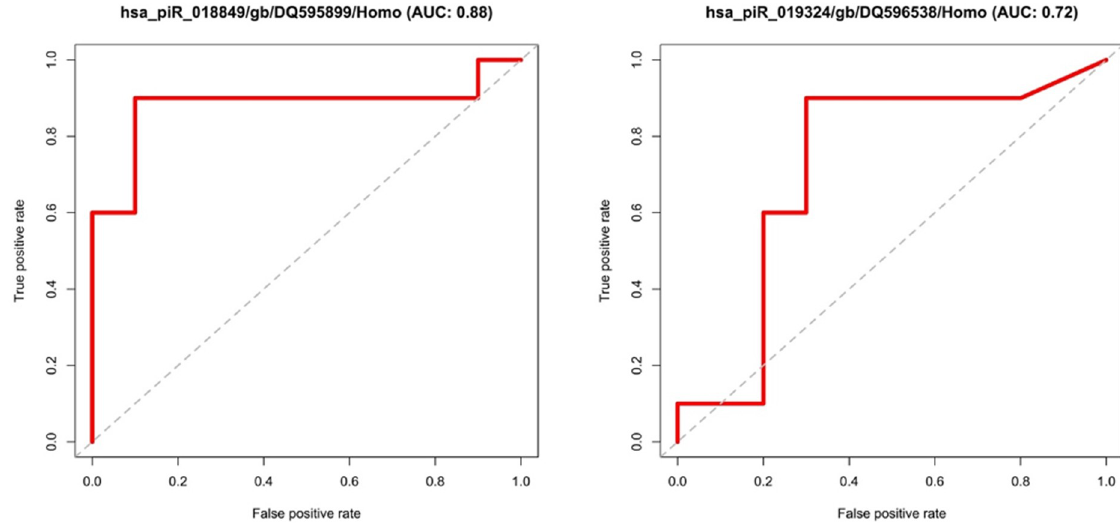
Fig 7. Validation of the panel of total